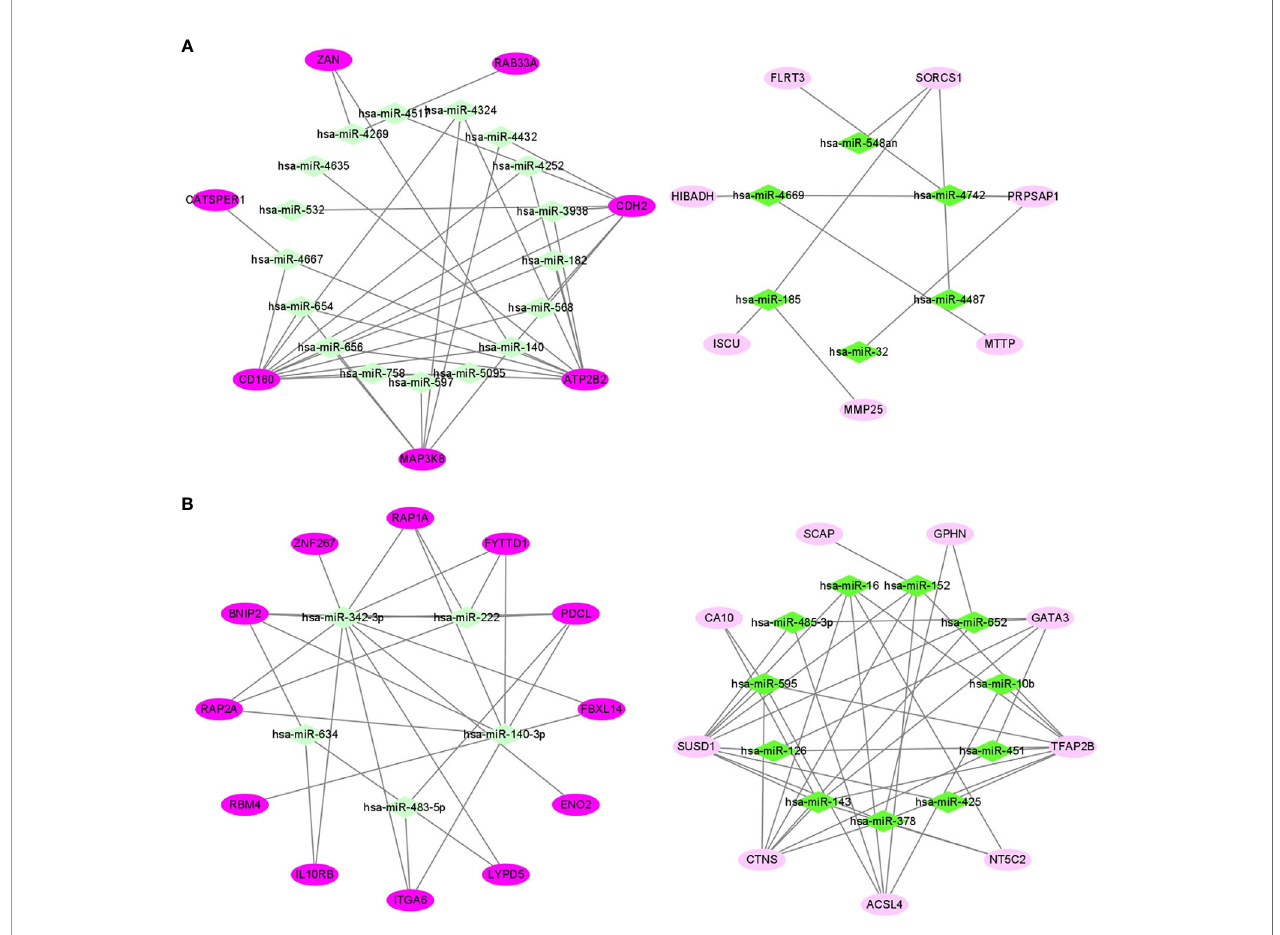
FIGURE 5 | miRNA-mRNA networks of obesity-related ccRCC in VAT (A) and SAT (B) . In VAT (A) , 14 mRNAs and 23 miRNAs were included. In SAT (B) , 21 mRNAs and 16 miRNAs were included. Green diamonds represent miRNAs, and pink ellipses represent mRNAs. The color from dark to light respectively represents up- and